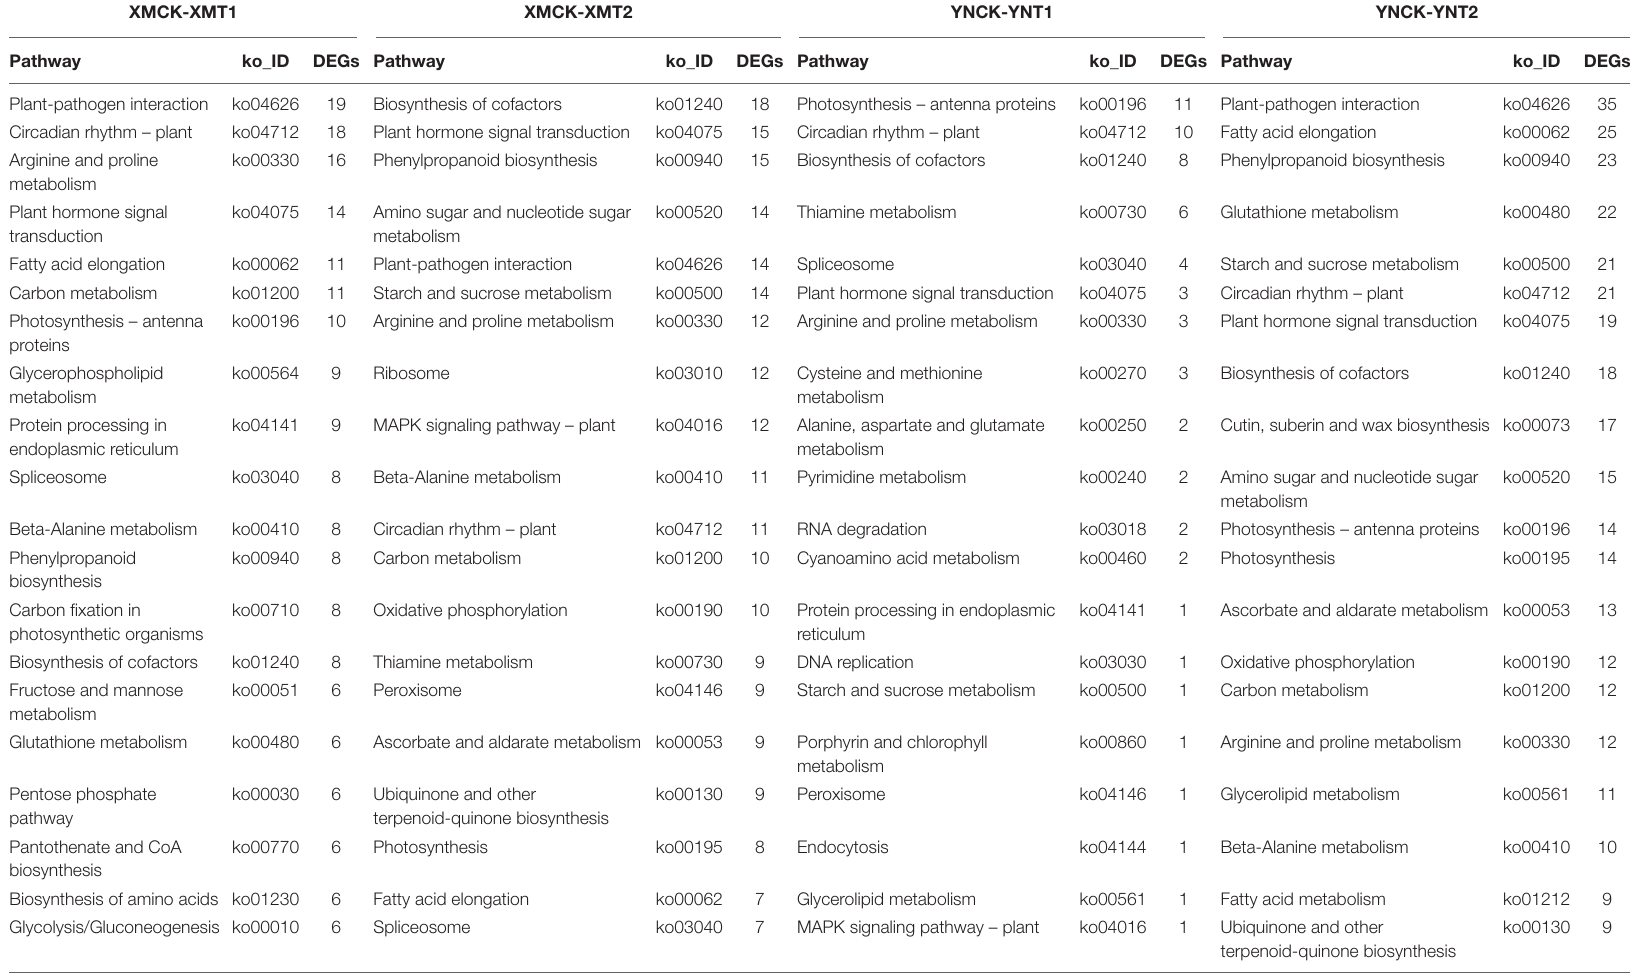
TABLE 4 | The top 20 KEGG pathways with the largest number of differentially expressed genes in each comparison